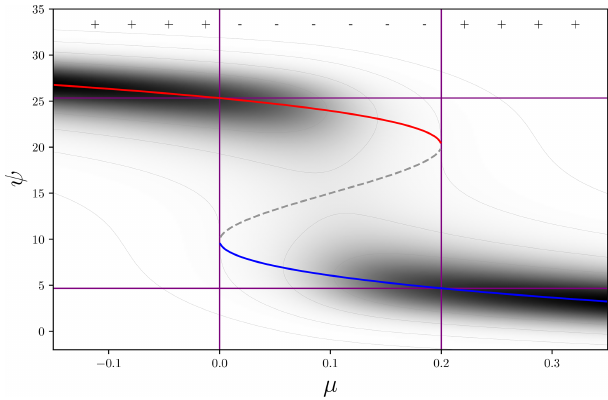
Figure 4. Example trajectory with corresponding distribution. Pa- rameterised by λ = 15, ν = 20, σ = 0 . 12 ν , µ + = 0 . 2, µ − = 0, β 0 = 0 . 2, and δβ = 0; α 0 and δα follow the constraints in Eqs. (4) and (5). The distribution of one of the attractor branches (red: on state; blue: off state) deforms when closer to the bifurcation points that are connected though the repeller that forms the trench of the distribution (dashed line). Top ± symbols indicate a unimodal ( + ) or bimodal ( − ) regime based on the discriminant value ( D ). The value of σ is relatively large and is chosen for clarity. The purple lines indicate the (fixed) positions of the bifurcation points.